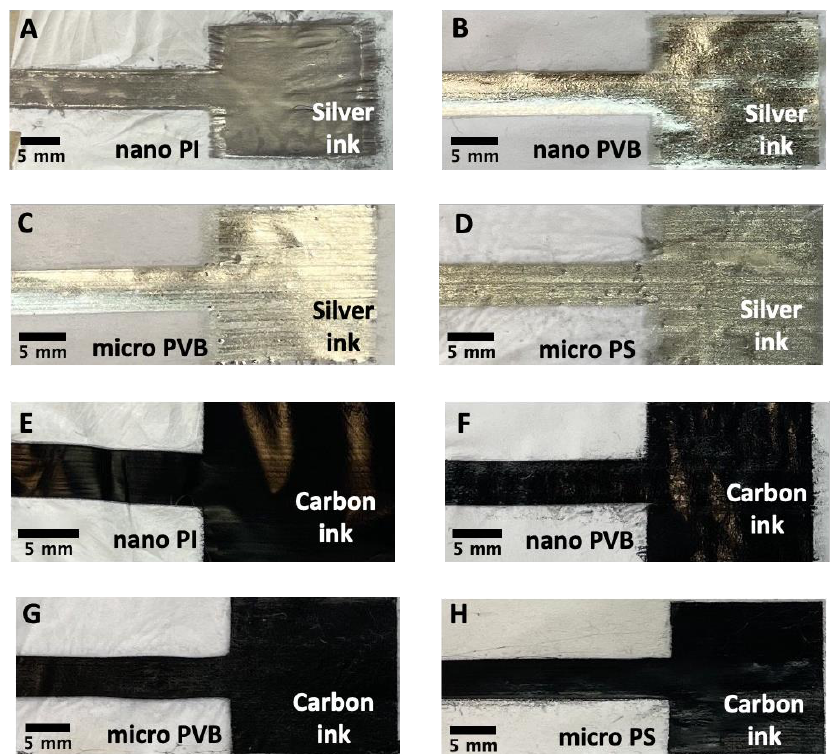
Figure 6. Macroscopic images of electrospun membranes built of nanofibers ( A , E ) PI and ( B , F ) PVB; microfibers ( C , G ) PVB and ( D , H ) PS printed with two layers of silver ad carob ink respectively. All pictures were taken after sintering step.